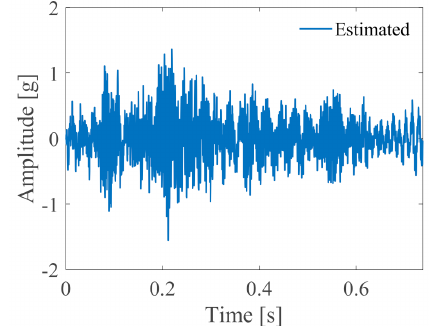
Figure 14. Estimated sensitive signal in inner race fault experiment.